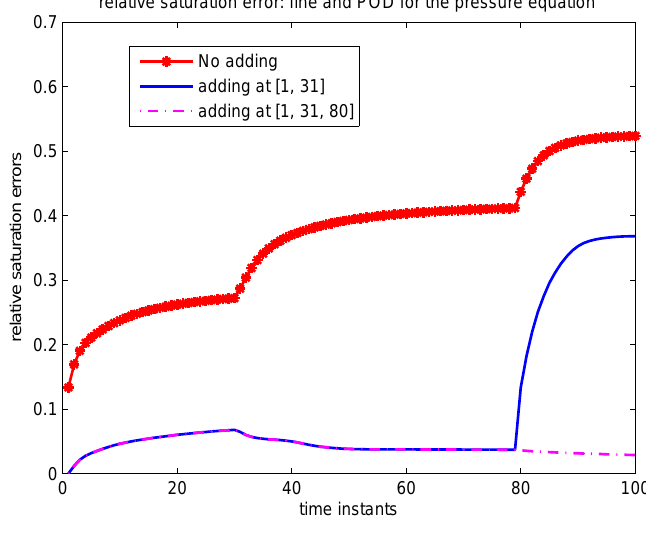
Figure 9. Relative saturation errors advancing in time: POD for the pressure equation.